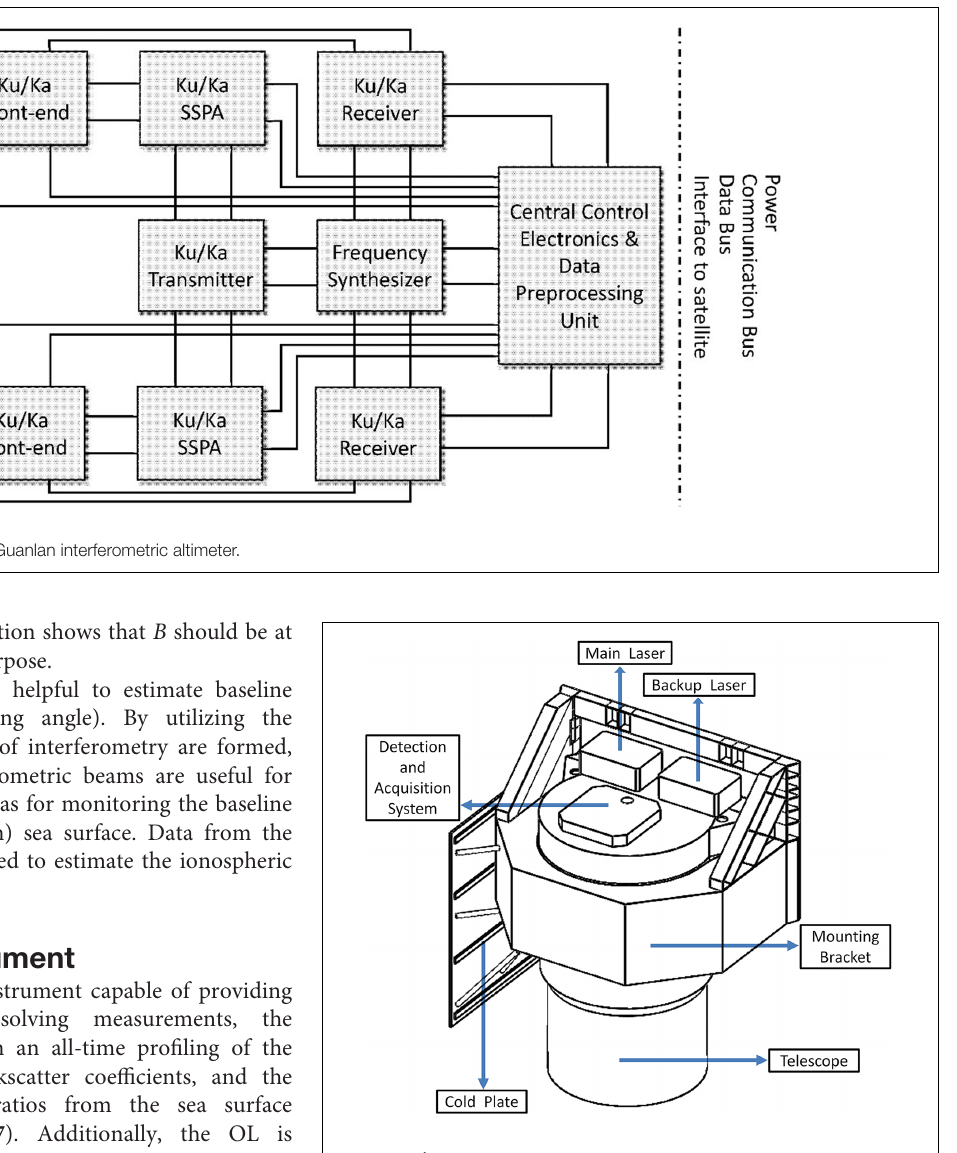
FIGURE 7 | Configuration of the Guanlan ocean